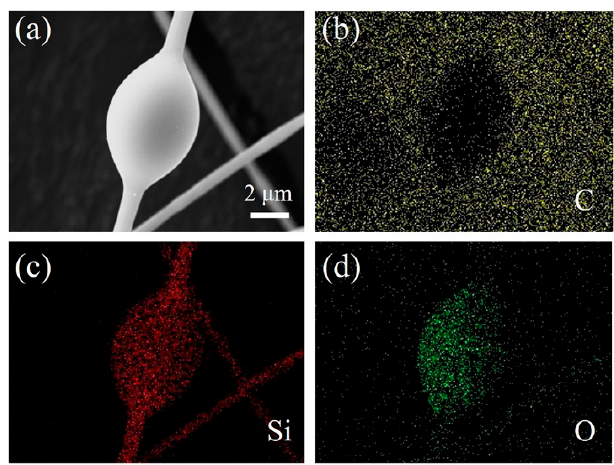
Figure 5. Mapping the energy dispersive X-ray spectroscopy (EDS) patterns of the SiC/SiO 2 heterojunctions synthesized at 1200 °C: ( a ) SEM images of the products; ( b ) C element; ( c ) Si element; ( d ) O element.